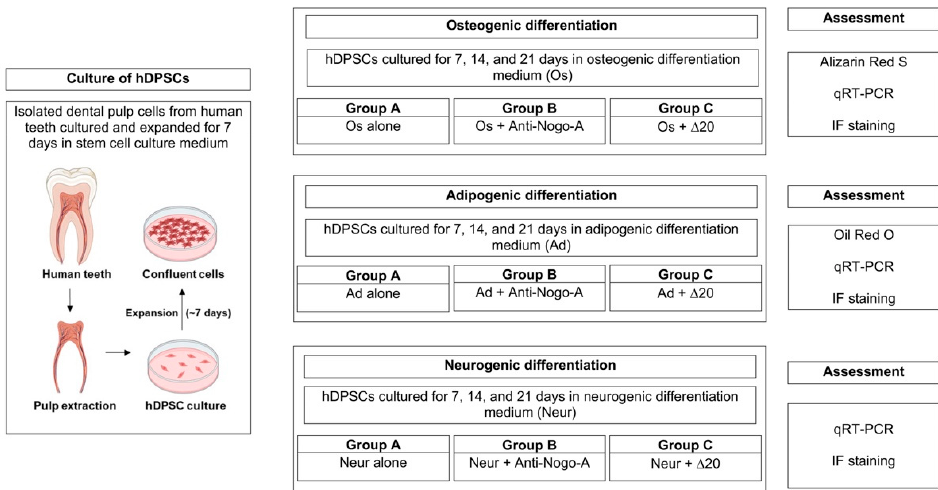
Figure 1. Experimental plan for analyzing the effects of Nogo-A (Nogo-A Δ 20 fragment) and anti- Nogo-A antibody on the osteogenic, adipogenic, and neurogenic differentiation of human dental pulp stem cells.